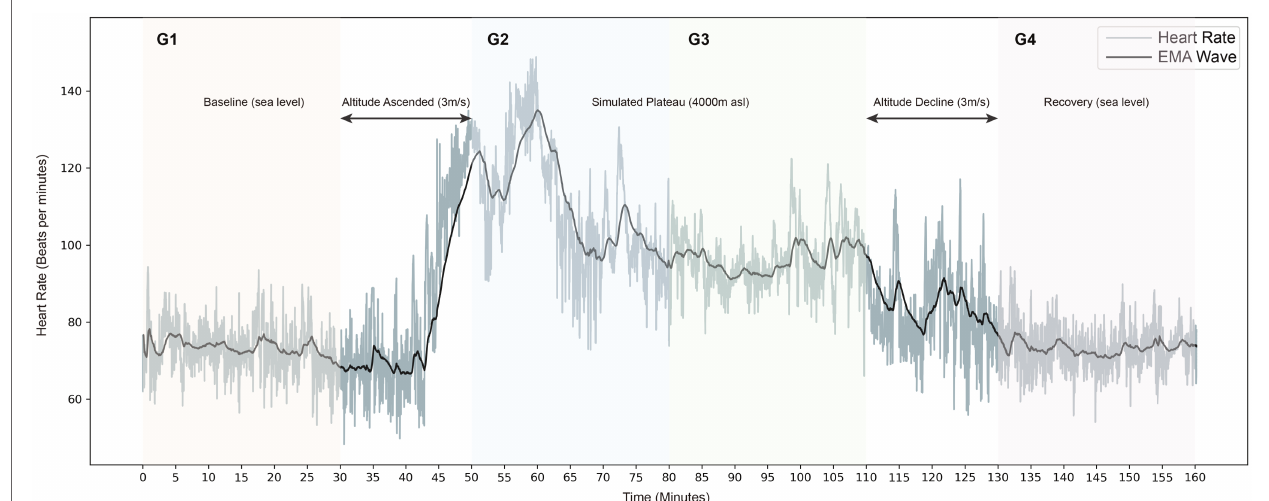
FIGURE 1 | Longitudinal heart rate tachogram is shown in grey, and the exponential smoothing averaging (EMA) is